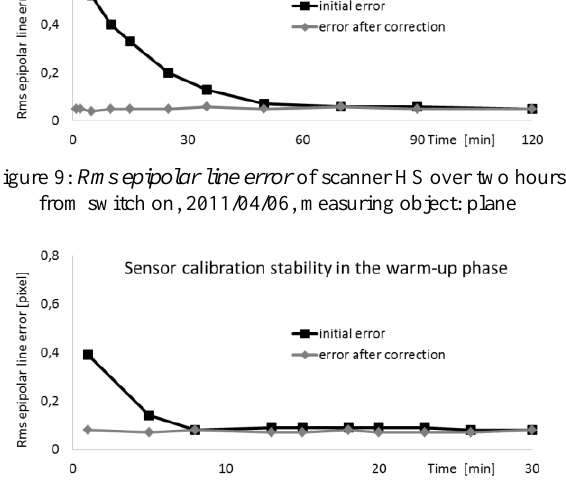
Figure 10: Rms epipolar line error of scanner CS 1 over 30 min.